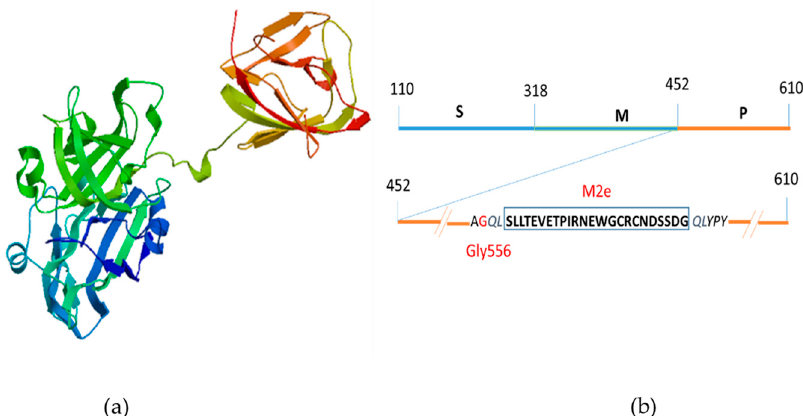
Figure 5. Schematic diagram of the chimeric M2 HEV ORF 2 capsid protein; ( a ) 3D modeling of M2 HEV ORF 2 capsid protein by SWISS MODEL; ( b ) Insertion of 24 amino acid residues of Influenza A virus M2 peptide at the position Gly556 (red) on the P domain of HEV ORF2 capsid protein.